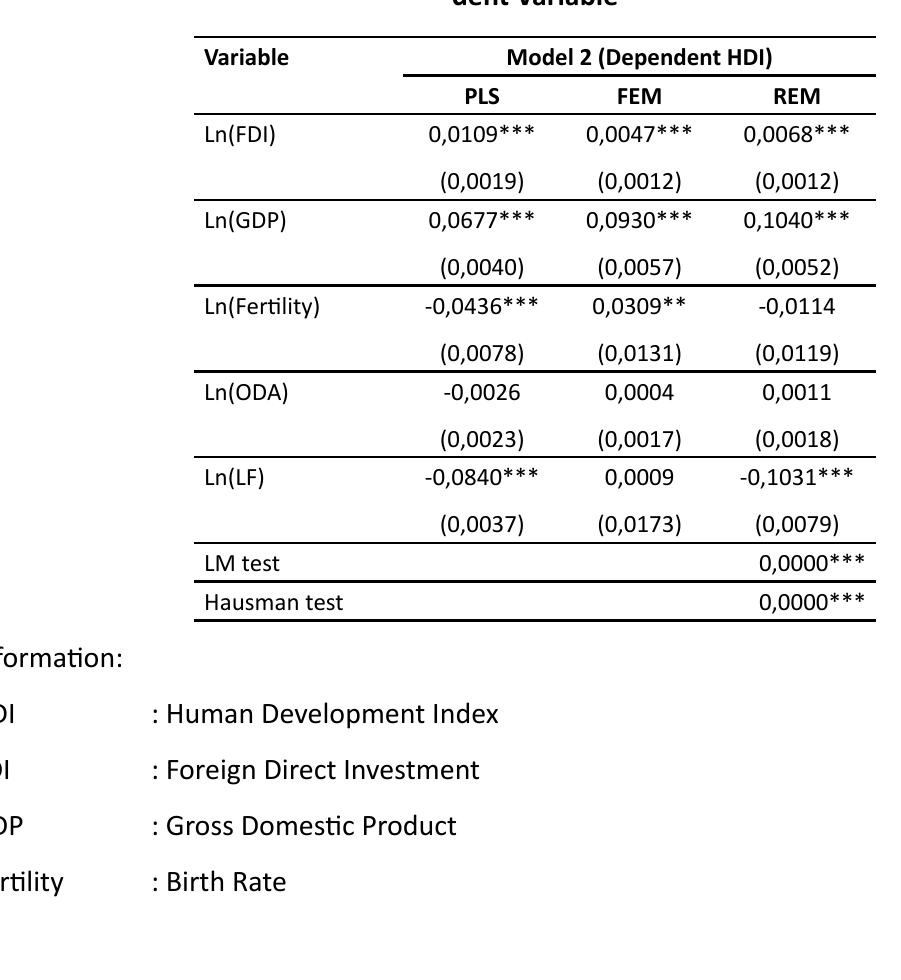
Table 2: Results of Estimation of Panel Data on the Human Development Index as Depen - dent